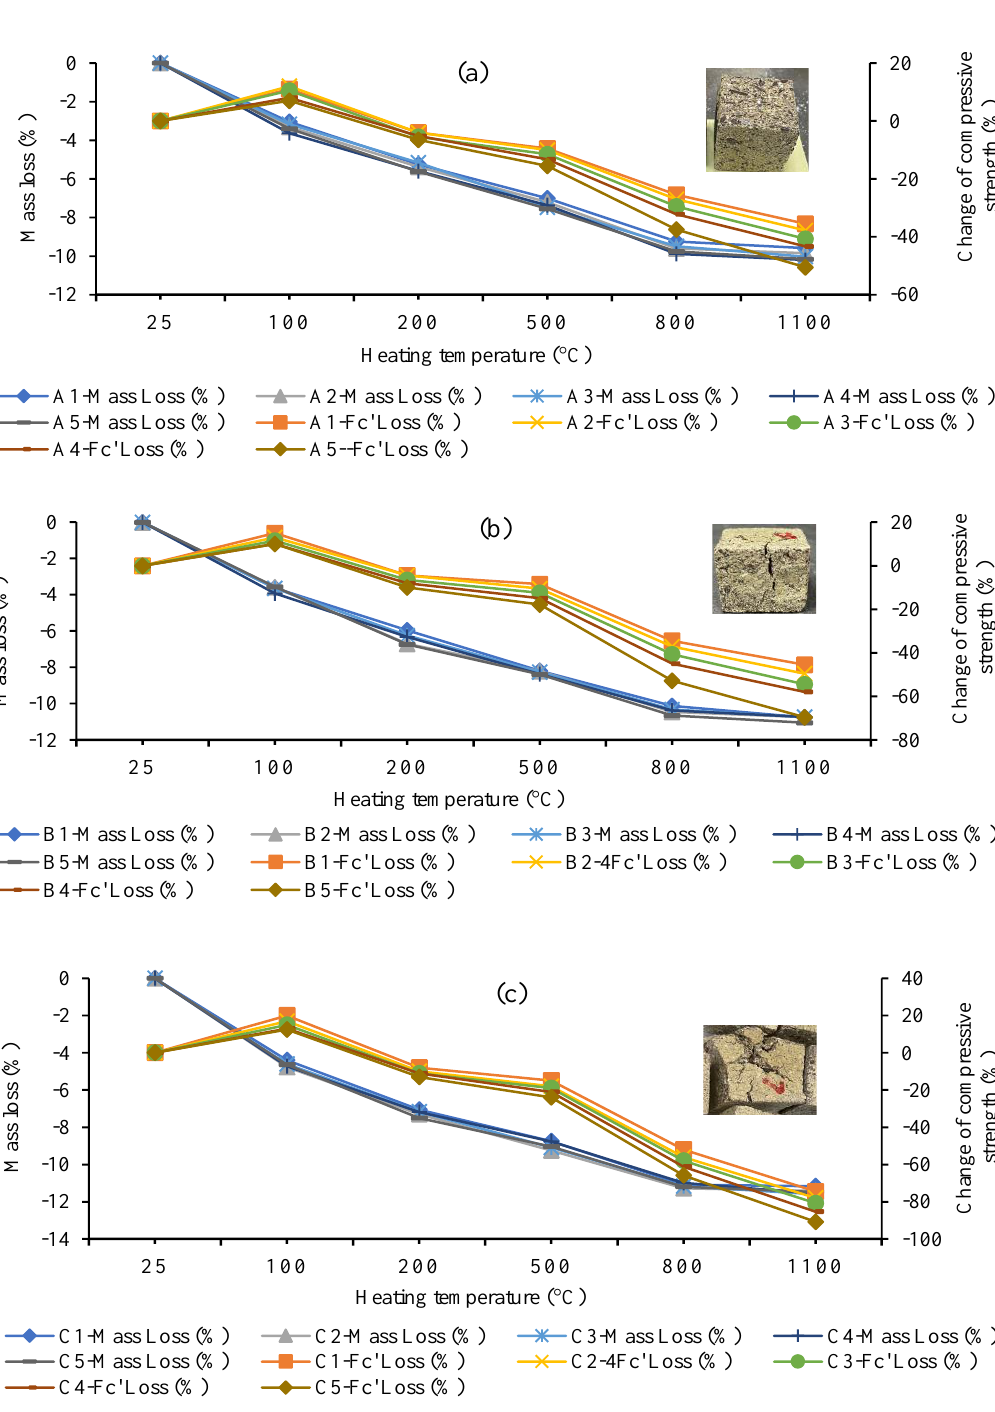
Figure 24. Relative change in mass loss (%) and compressive strength (%) of the geopolymer material using various Na 2 SiO 3 -to-NaOH and fly ash-to-GGBS ratios with sand preheated at 110 ◦ C: ( a ) Series A geopolymer paste; ( b ) Series B geopolymer paste; ( c ) Series C geopolymer paste.